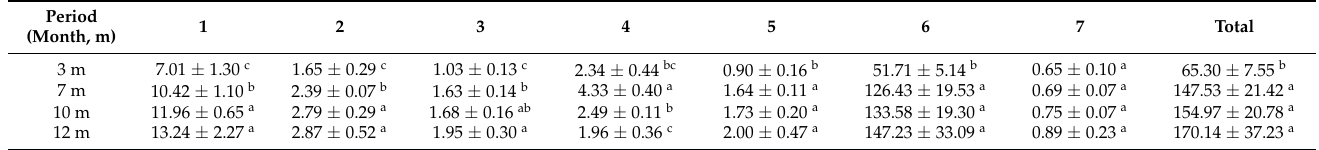
Table 3. Contents of seven lignans in an Omija beverage fermented with white sugar during different fermentation times. Period (Month,